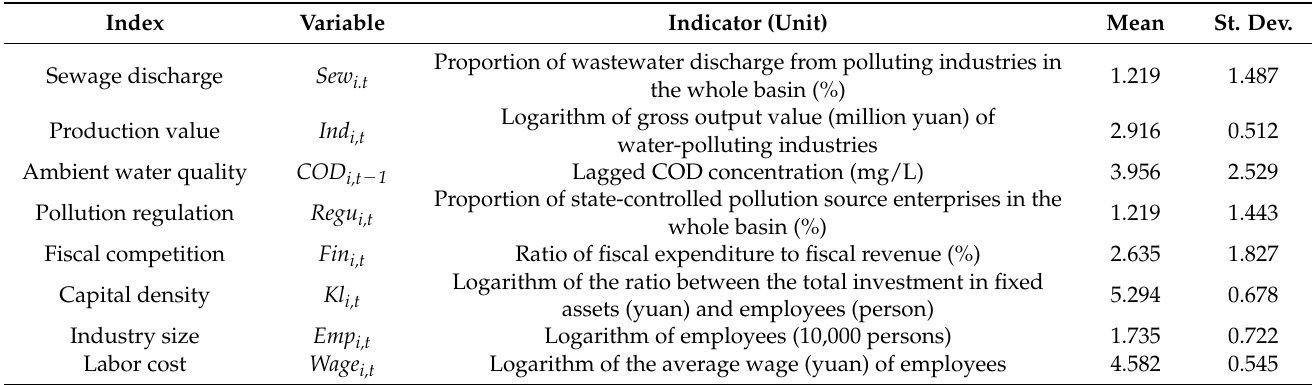
Table 1. Descriptive statistics of all